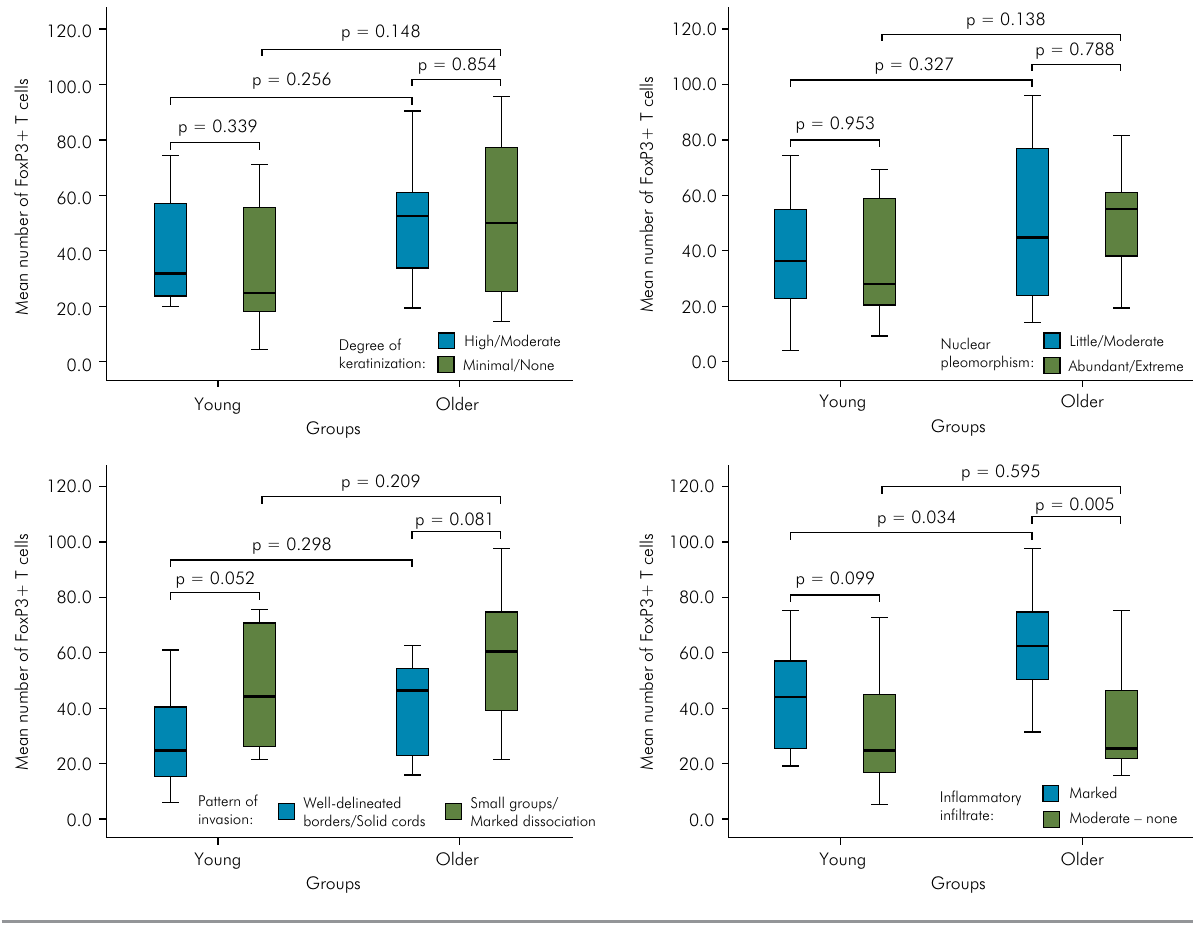
Figure 3. Box plot charts illustrating the number of FoxP3+ lymphocytes in OTSCC in young (≤ 45 years) and older (≥ 60 years) patients according to degree of keratinization, nuclear pleomorphism, pattern of invasion, and inflammatory